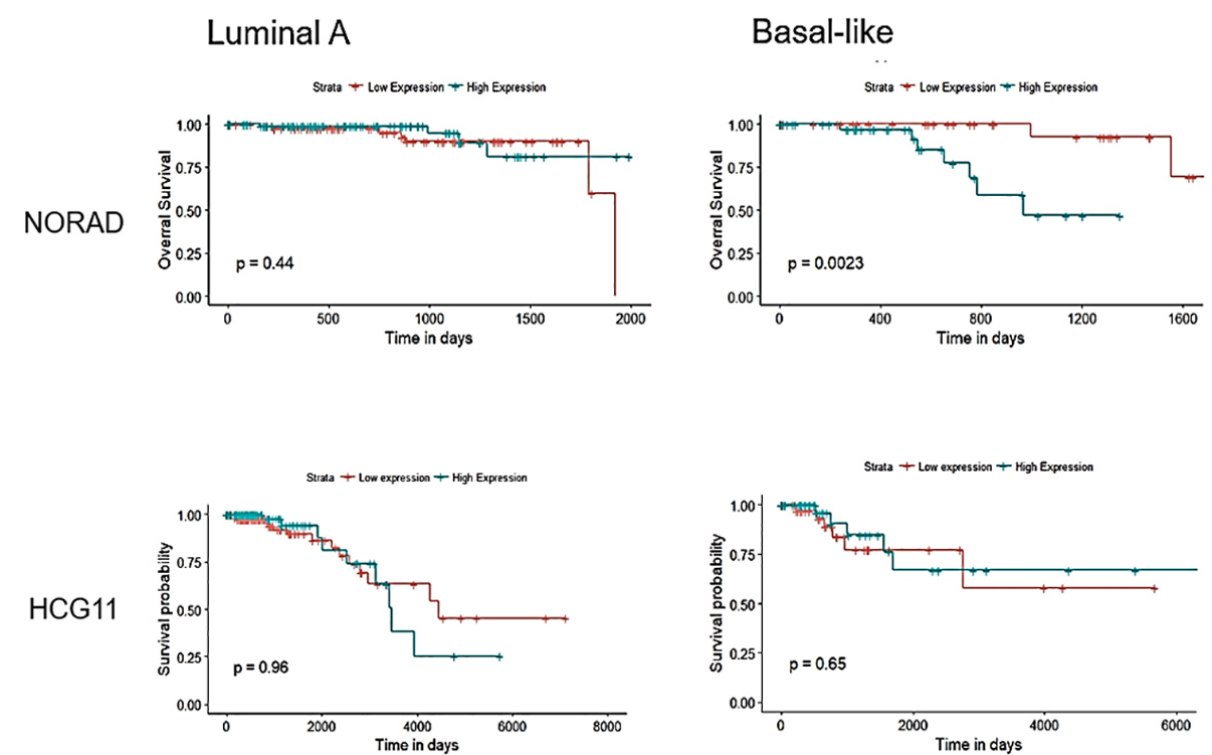
Figure 2 – Overall survival determined by the Kaplan-Meier plots method and the log-rank test according to NORAD and HCG11 expression (median value). Red and blue lines refer to patients with low and high expression, respectively. Disease-free survival information of breast cancer patients was downloaded from the TCGA